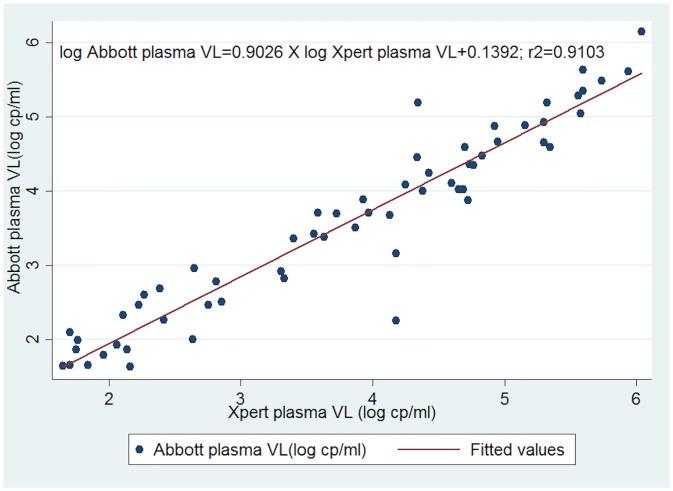
Scatter plot of log transformed viral loads of Abbott m2000 against GeneXpert plasma test.